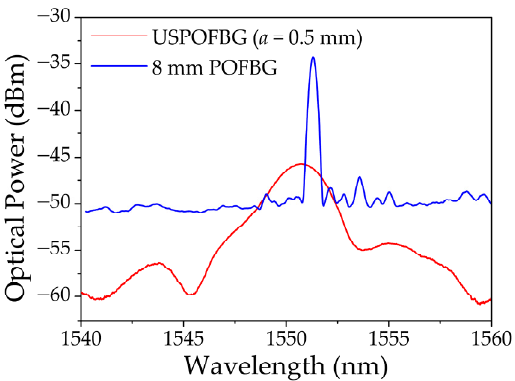
Figure 11. Reflection spectra of the 8 mm POFBG and USPOFBG employed in the sensing tests.